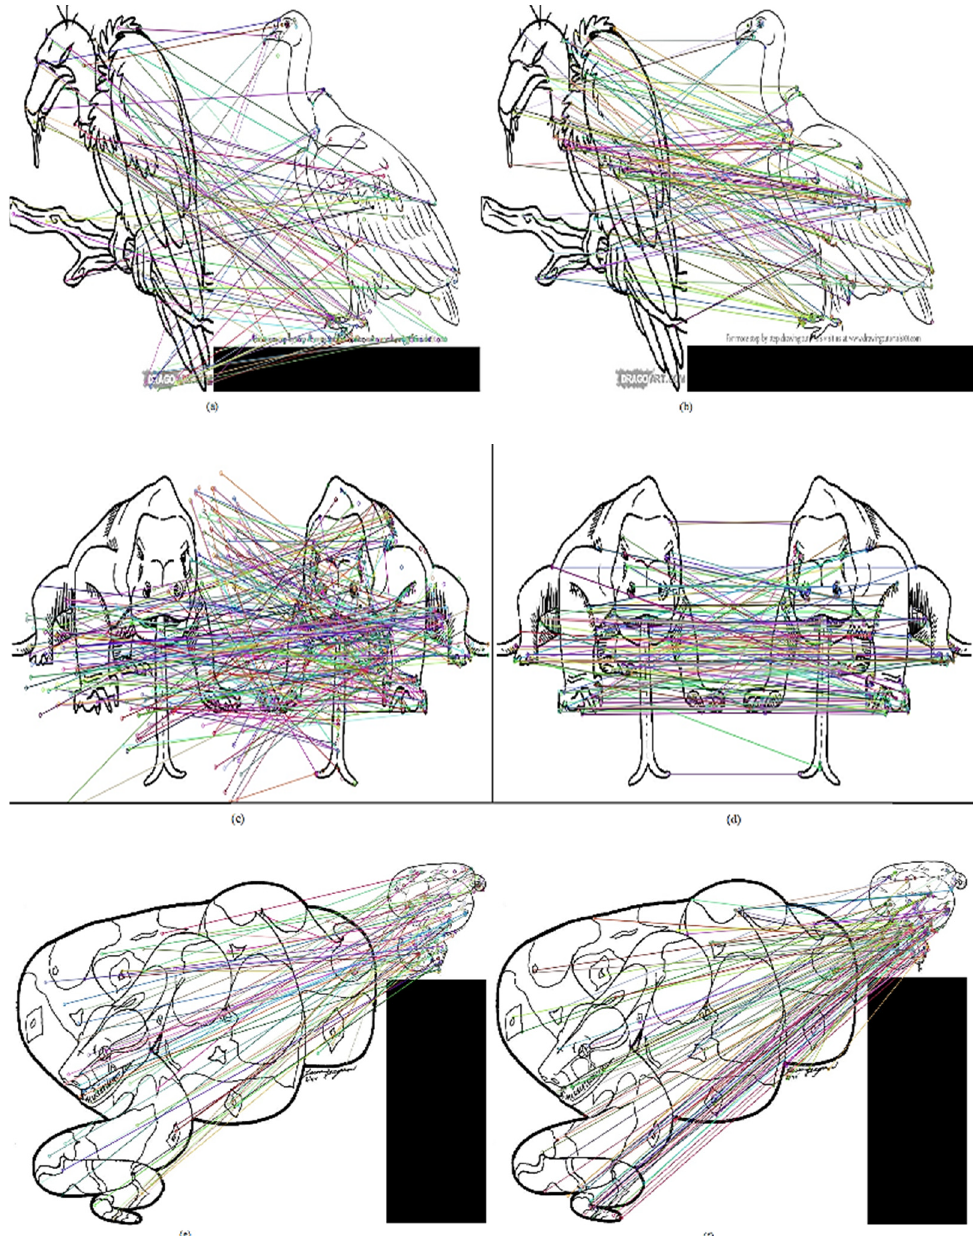
Figure 9. Matched points of ( a ) 1st pair for SIFT, ( b ) 1st pair for ORB, ( c ) 2nd pair for SIFT, and ( d ) 2nd pair for ORB [42].